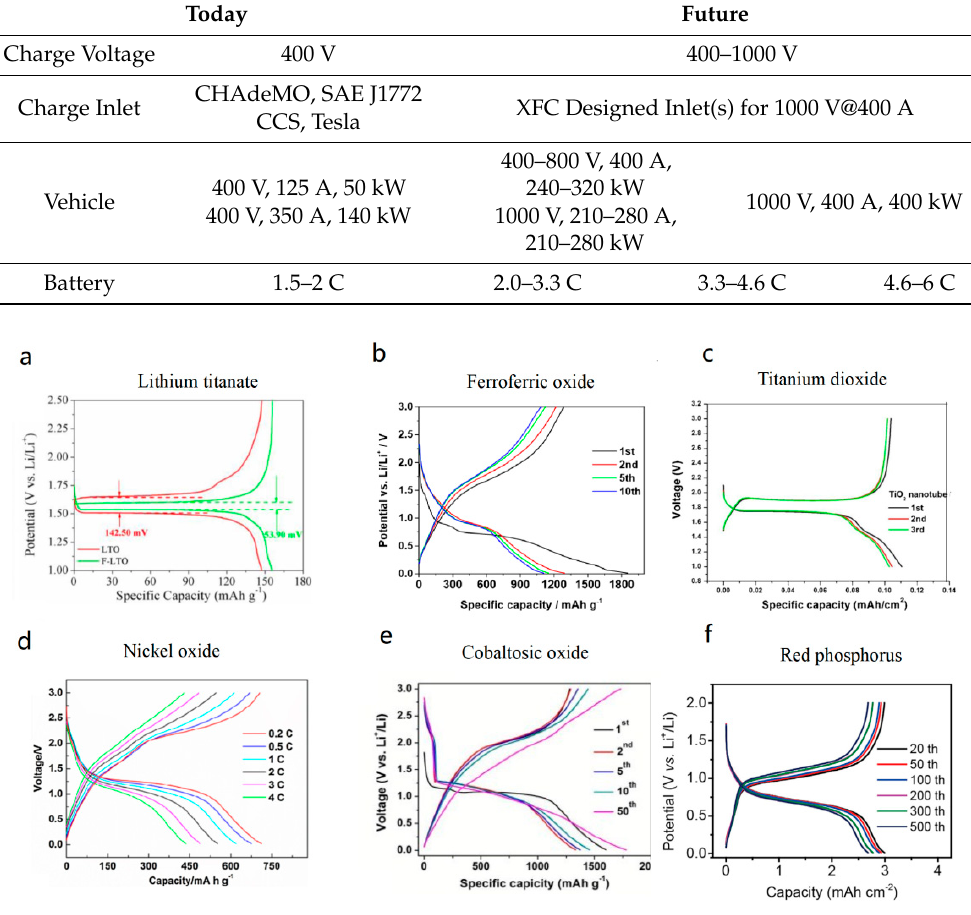
Figure 9. Charge–discharge curves of lithium titanate [84] ( a ), ferroferric oxide [97] ( b ), tatanium dioxide [98] ( c ), nickel oxide [99] ( d ), cobaltosic oxide [100] ( e ), and red phosphors [92] ( f ). Reproduced by permission of Royal Society of Chemistry, Elsevier, The Electrochemical Society, and